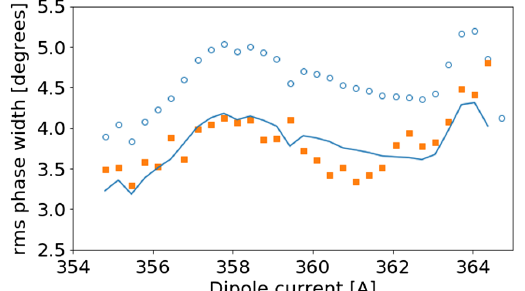
FIG. 20. Comparison of rms phase width at 1% threshold. Solid orange points are phase width measured with virtual slit tech- nique. Open blue points are result of “ typical ” measurement. The solid blue line is the same measurement with 83% correction factor